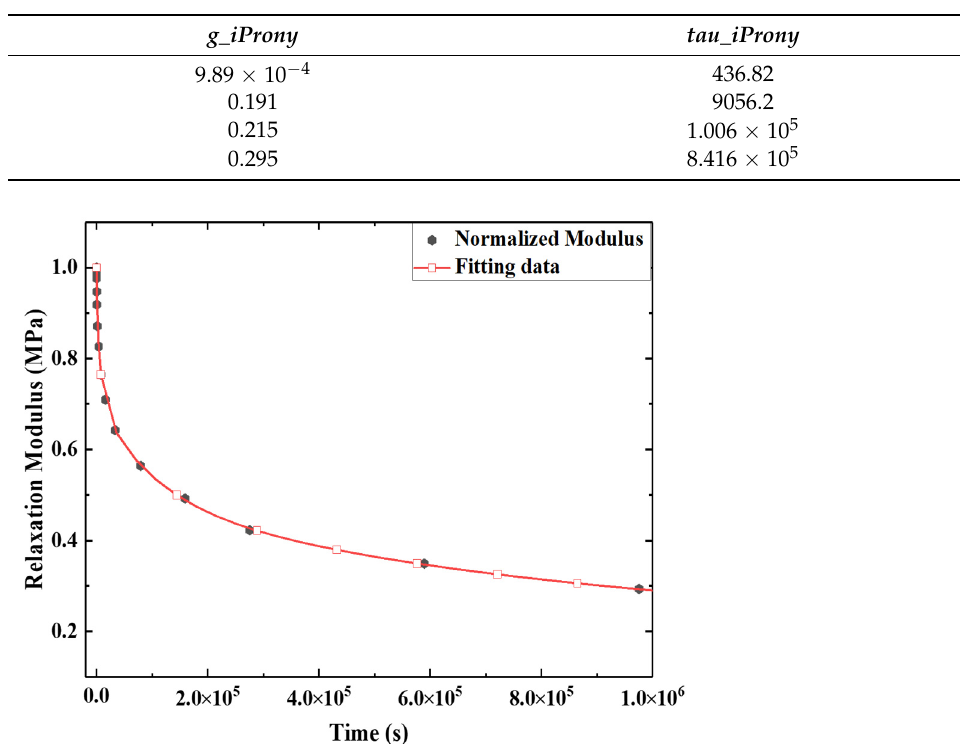
5 mm Figure 13. Schematic diagram of the test piece.